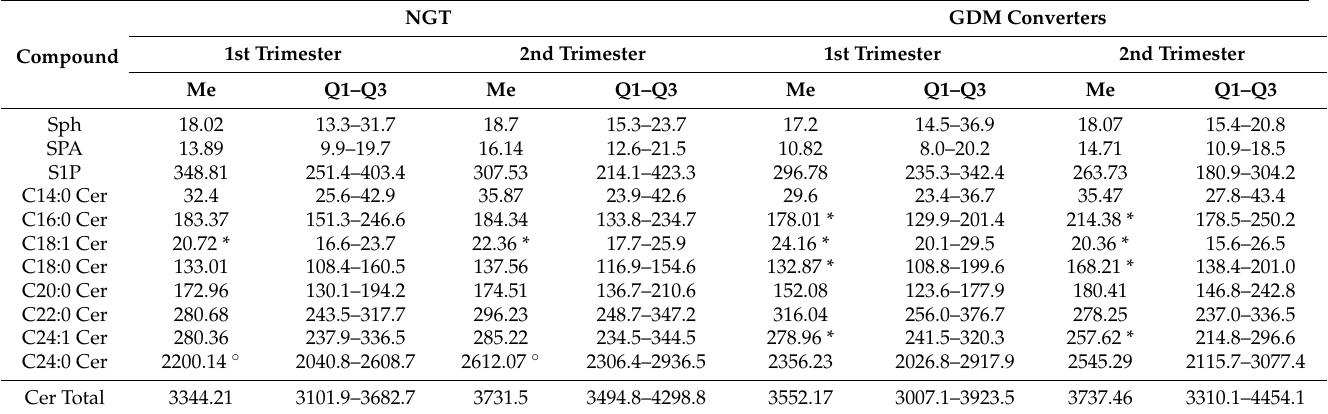
Table 4. The concentration of sphingolipids in the serum of patients from the GDM and NGT groups by